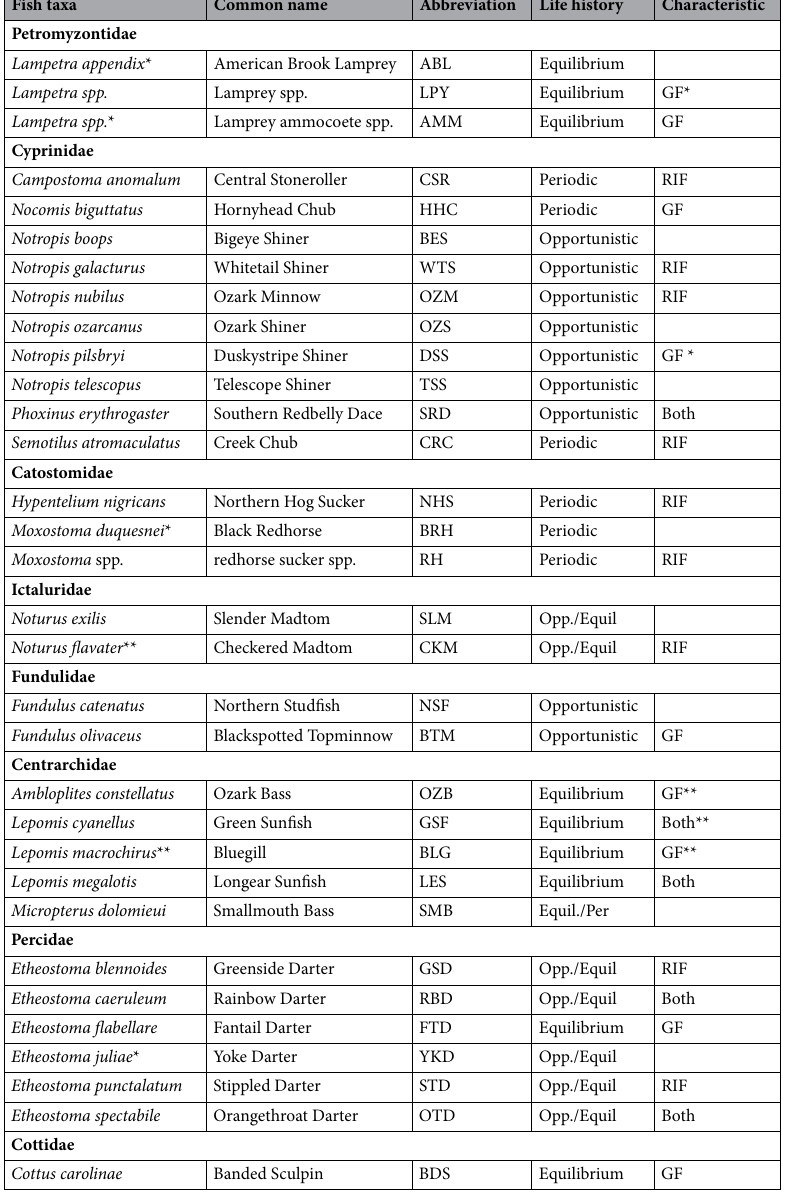
Table 2. Fish species collected in 2002 and 2003 and associated life history strategies. Characteristic species were based on high relative densities in Runoff/Intermittent Flashy (RIF), Groundwater Flashy (GF) or both. Life history strategy as in 12 . *only in 2002, **only in